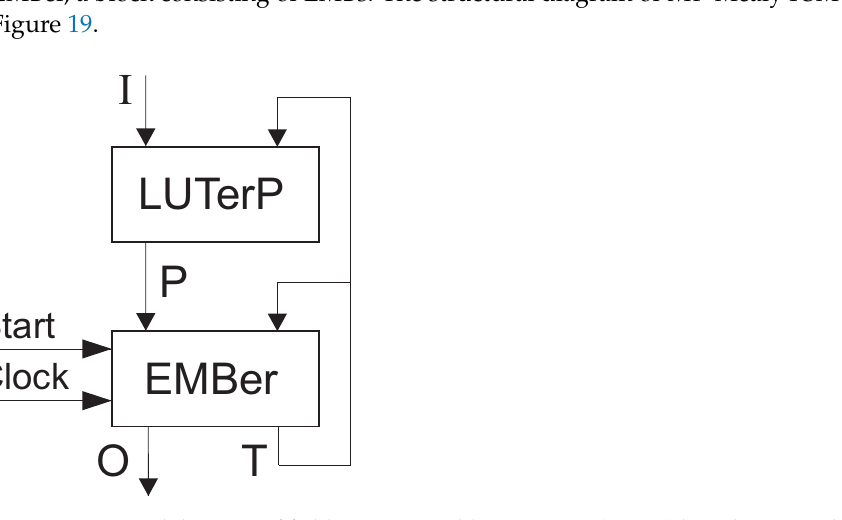
Figure 19. Structural diagram of field-programmable gate array (FPGA)-based MP Mealy FSM.